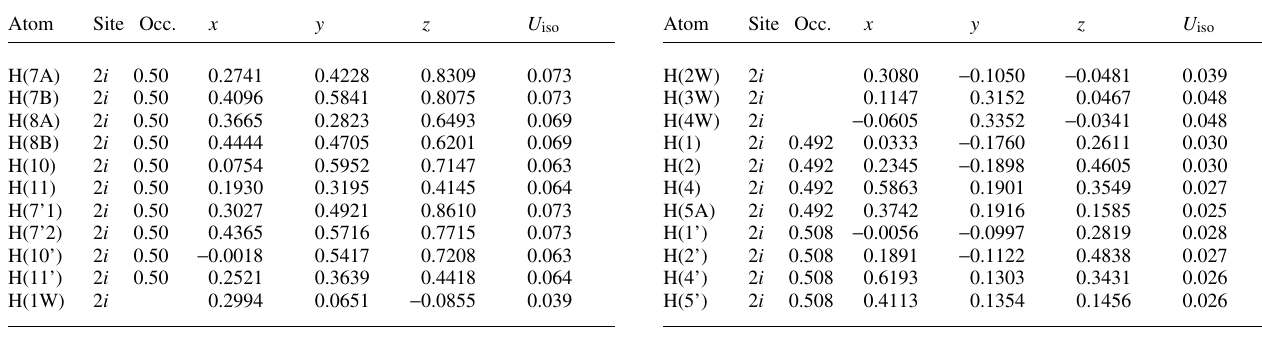
Table 3. Atomic coordinates and displacement parameters (in Å 2 ) .